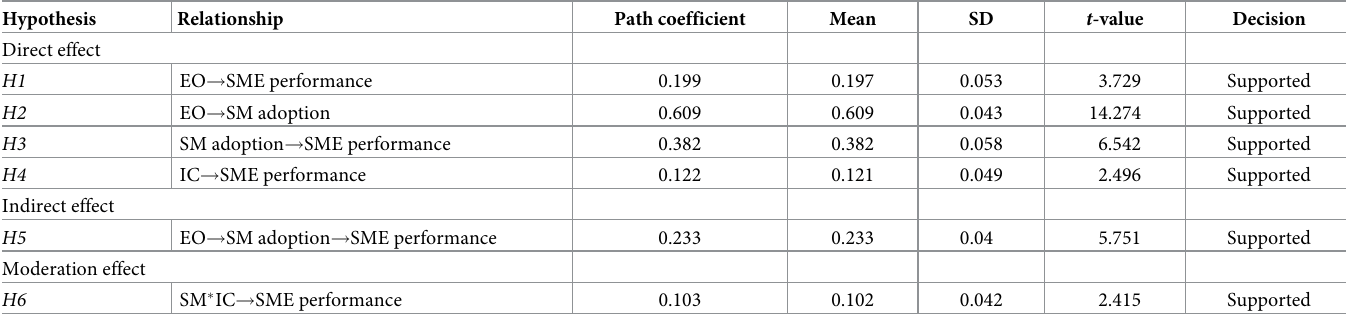
Table 6. Path coefficient and hypotheses testing.